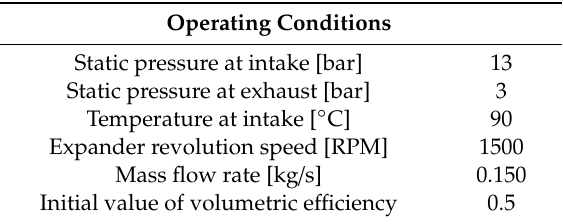
Table 3. Operating